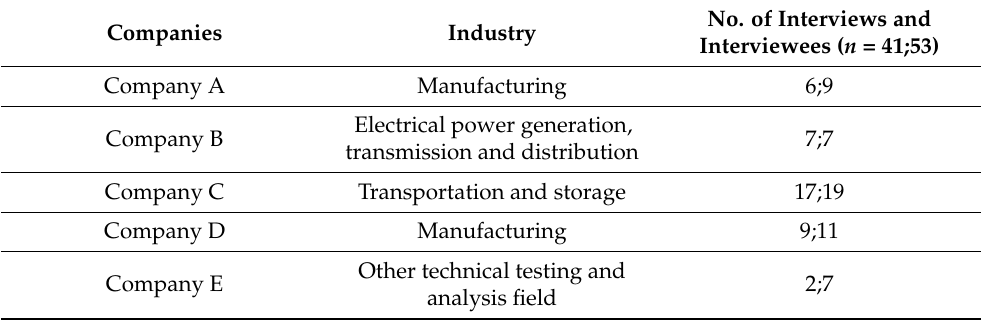
Table 2. Background information about the interviews ( n = 41) and interviewees ( n =